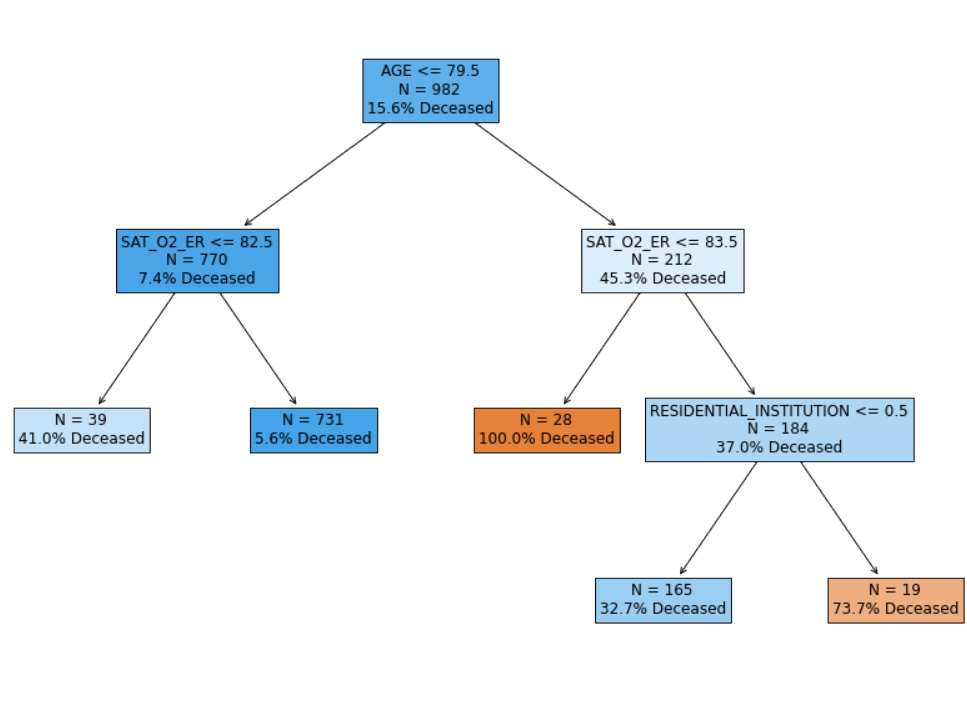
Figure 6. Decision tree.